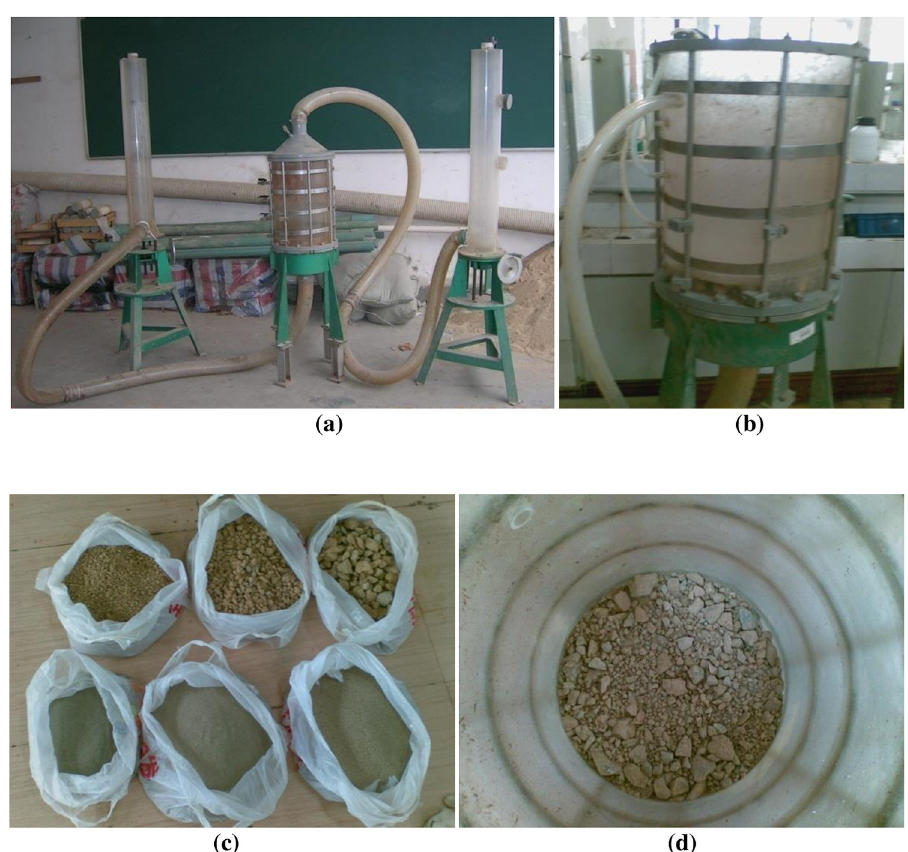
Fig 1. The test device and sample materials in seepage test: (a) device overview; (b) sample container; (c) sample materials with different particle sizes; (d) material filling process.